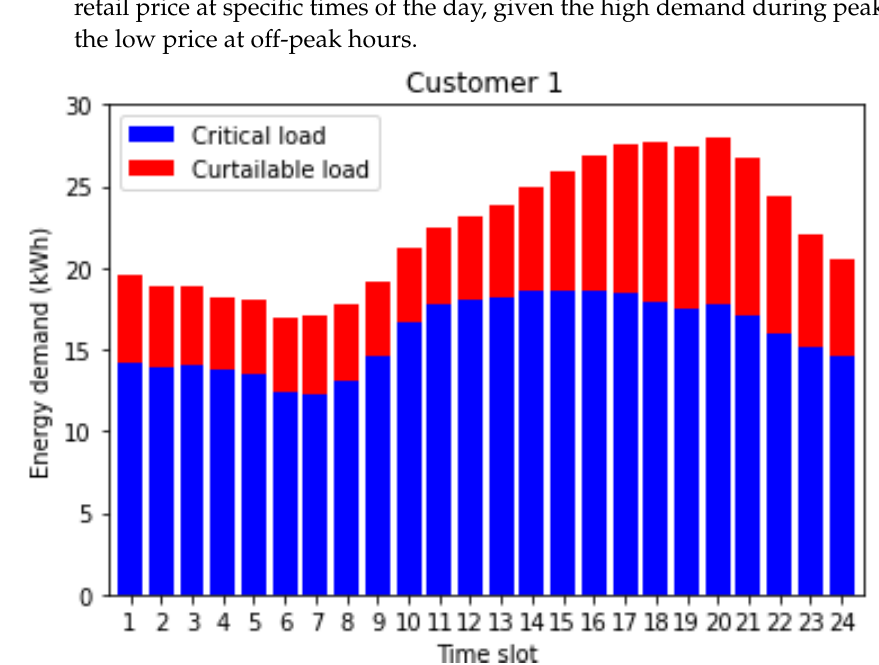
Figure 10. Critical and curtailable load for customer